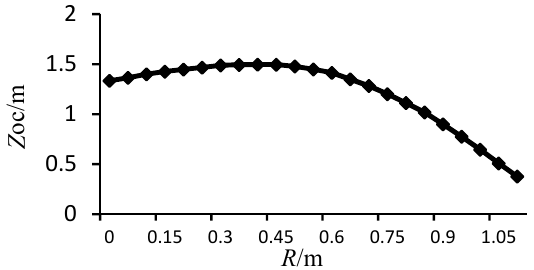
Figure 9. Maximum vertical impact force through varying tip radius.